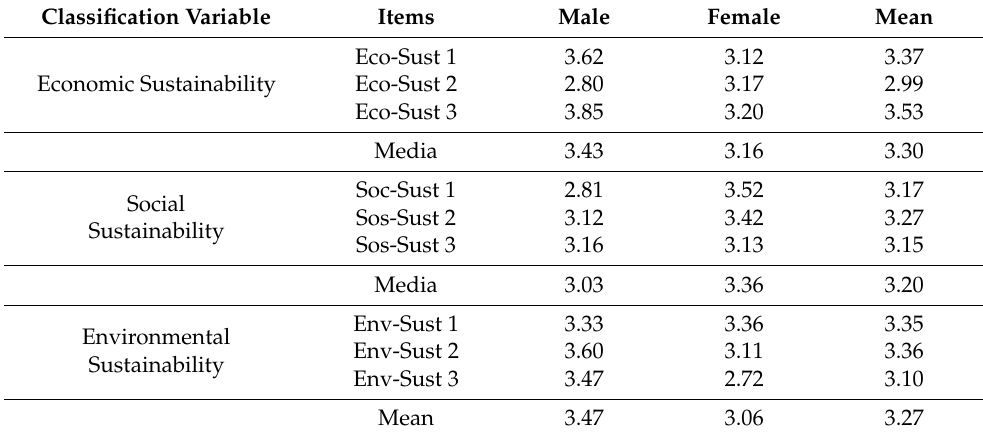
Table 2. Means of the variables according to gender. Classification Variable Items Male Female Economic